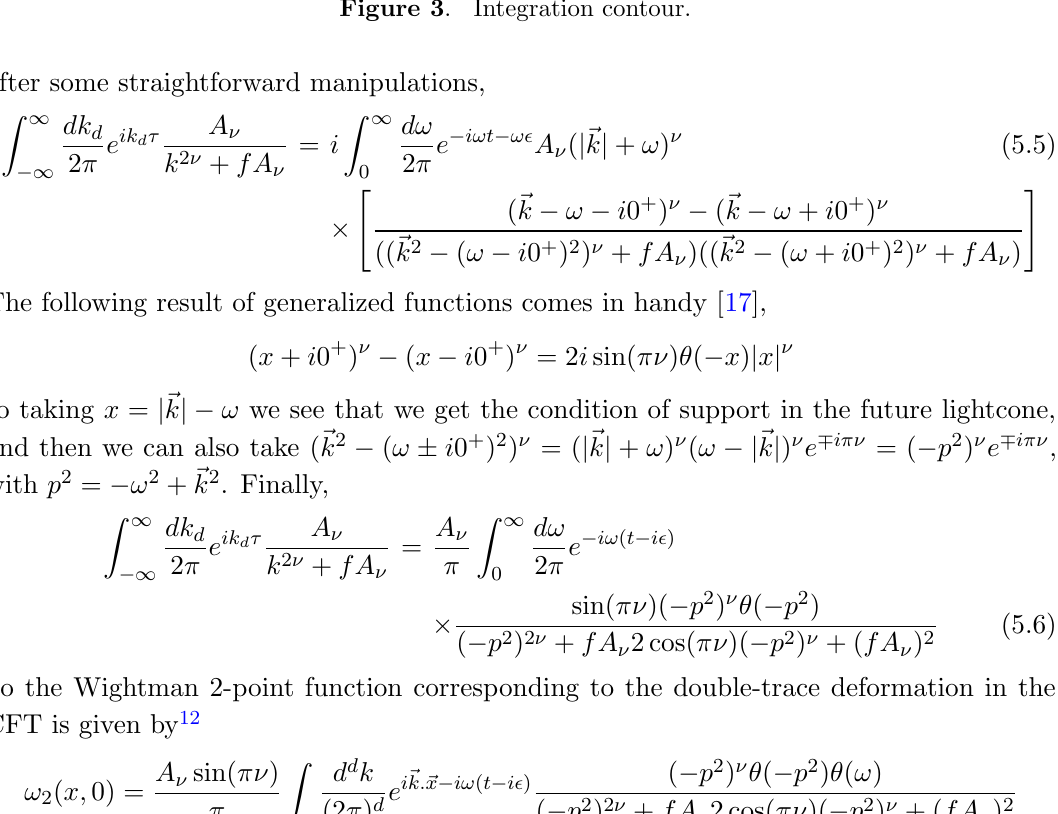
Figure 3 . Integration